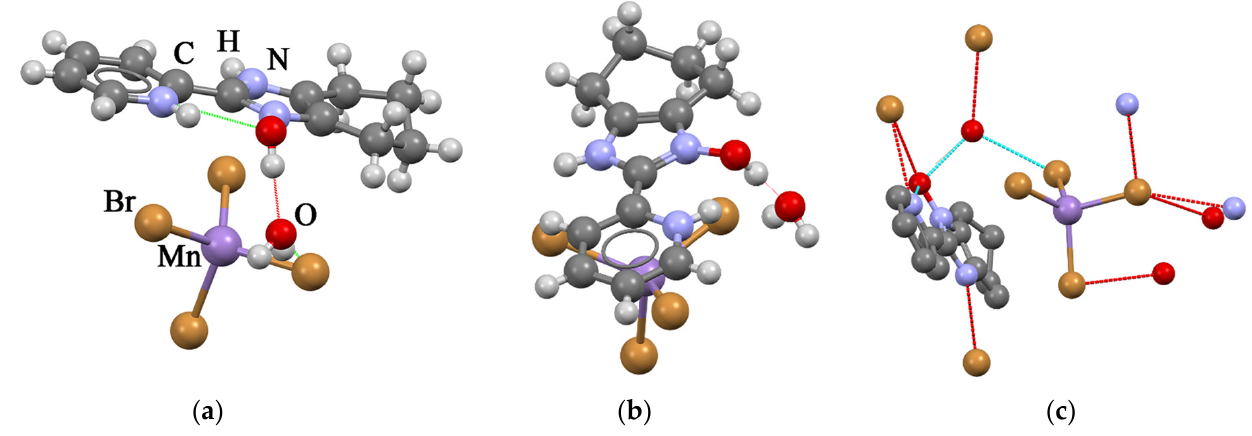
Figure 1. Structure of [H 3 L][MnBr 4 ][H 2 O] moiety of 1: ( a ) against and ( b ) along [112] directions; and ( c ) along [100] with omitted hydrogen atoms. The hydrogen bonds presented by red, green, and cyan lines.